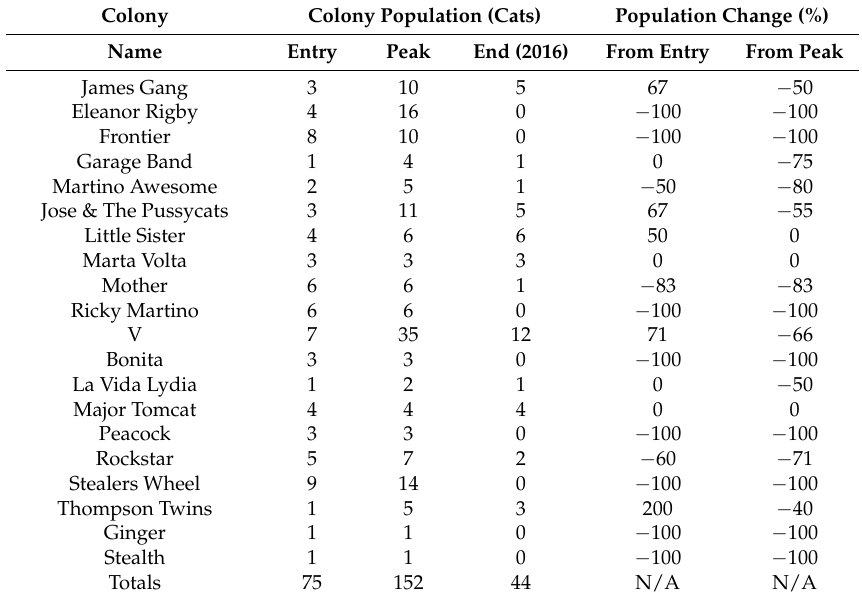
Table 4. Colony size at entry, peak, and end, and percentage change at end from entry size and peak size.